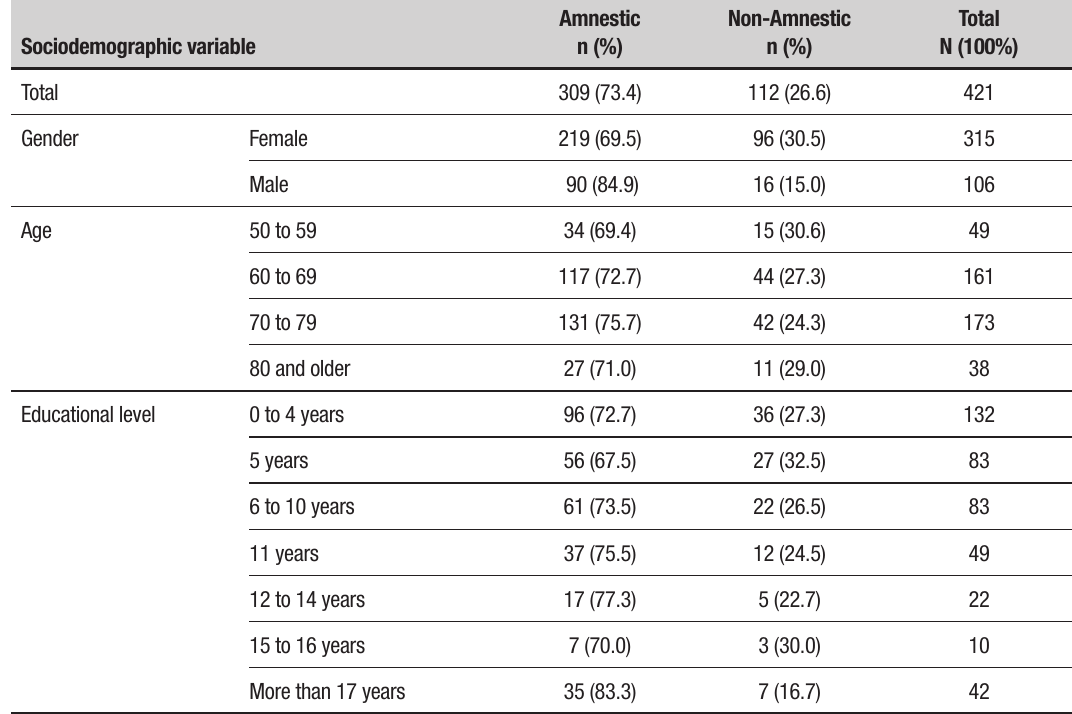
Table 3. Prevalence of amnestic and non-amnestic MCI by gender, age and educational level. Sociodemographic